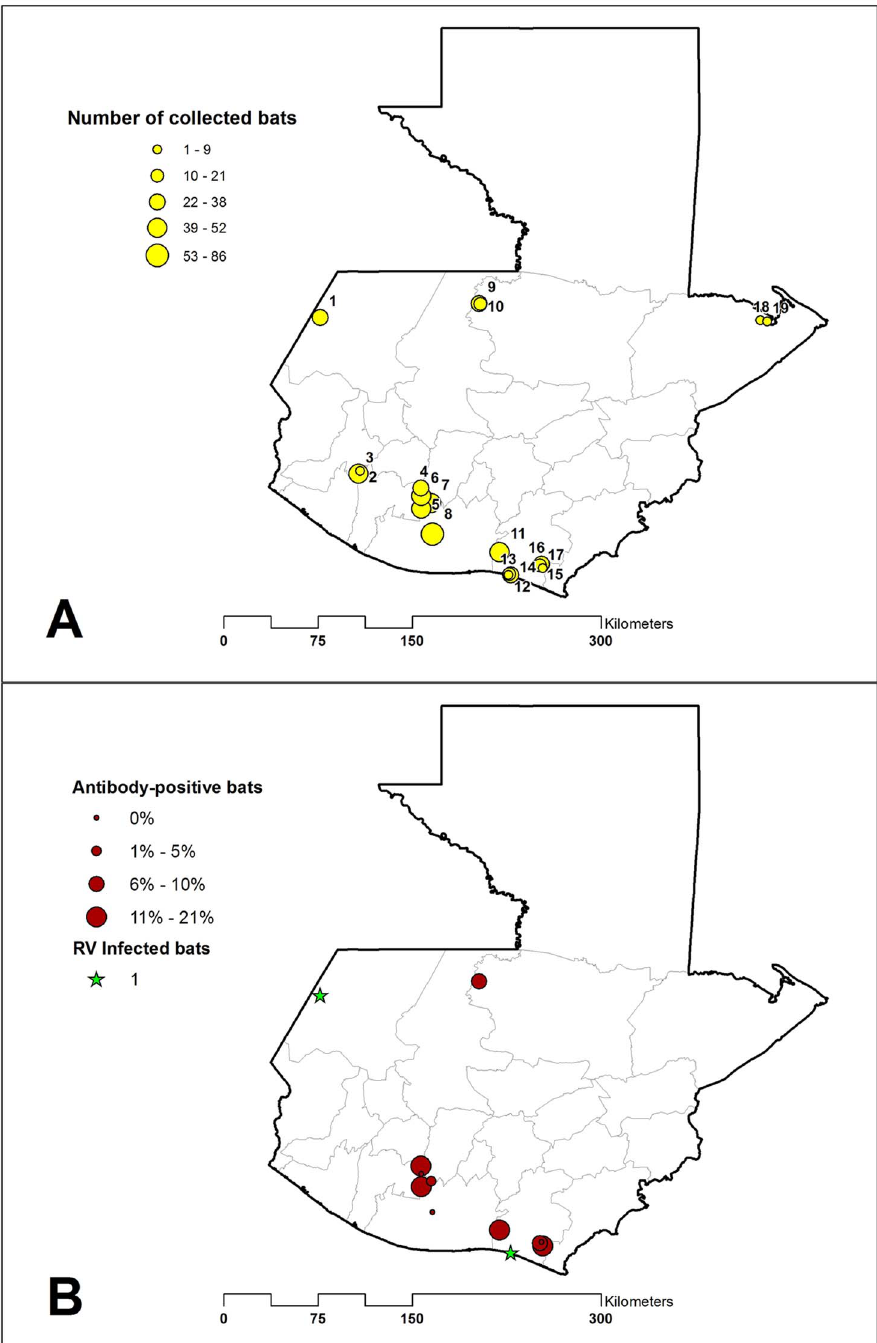
Figure 1. Map of selected field sites, Guatemala 2009–2011. (A) Yellow circles indicate the location 19 sites where bats were tested for RABV antigen and circle size is proportional to the number of bats collected. (B) Red circles indicate the location of ten sites where sera were available for rVNA testing and circle size is proportion to the level of rVNA seroprevalence among tested bats. The location of two rabies infected vampire bats ( D. rotundus ) is indicated by green stars.